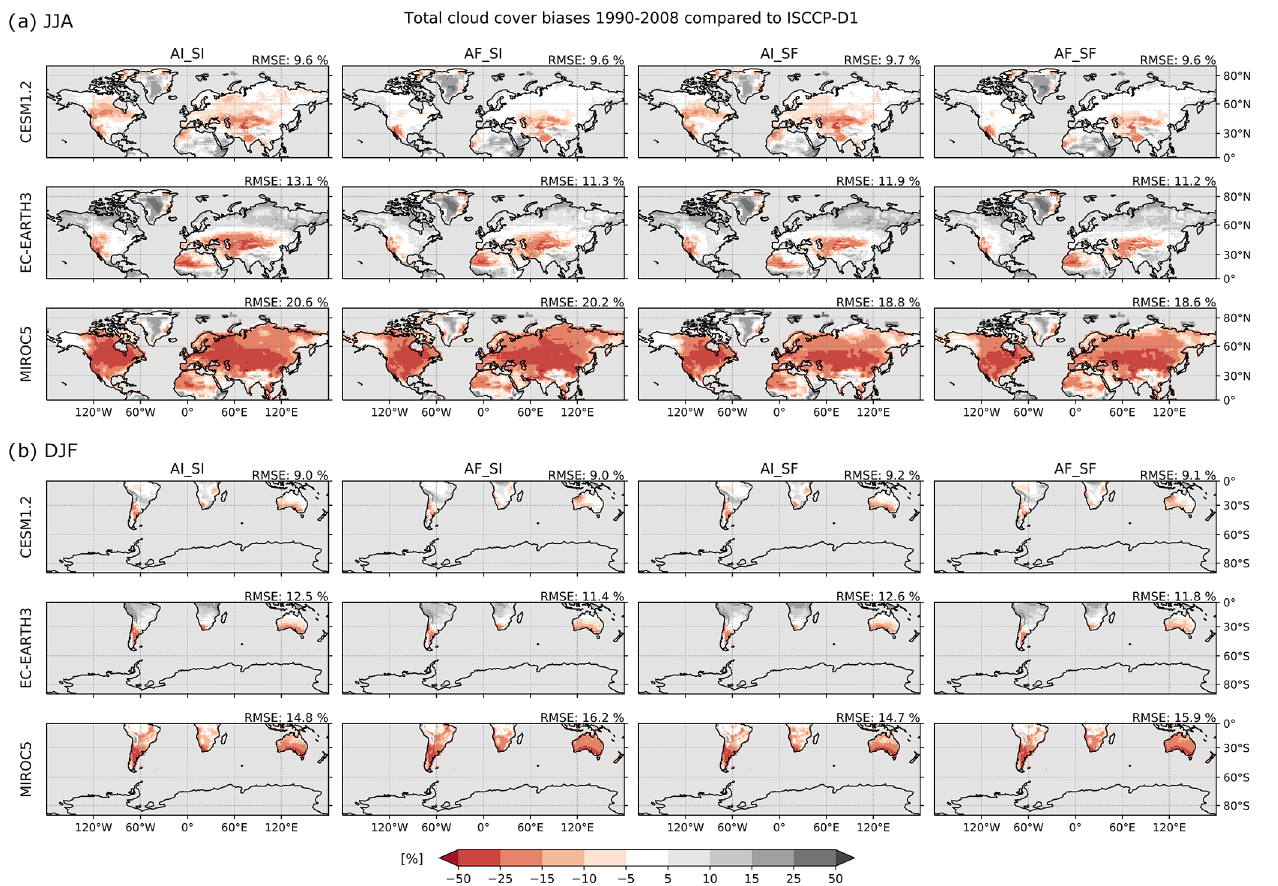
Figure A4. Bias in total cloud cover with respect to ISCCP-D1. Average over (a) JJA for the Northern Hemisphere and (b) DJF for the Southern Hemisphere. Ocean grid points and Antarctica are masked out. The RMSE averaged over all valid grid points of the respective hemisphere is given in millimeters per day in the upper right corner of each experiment and